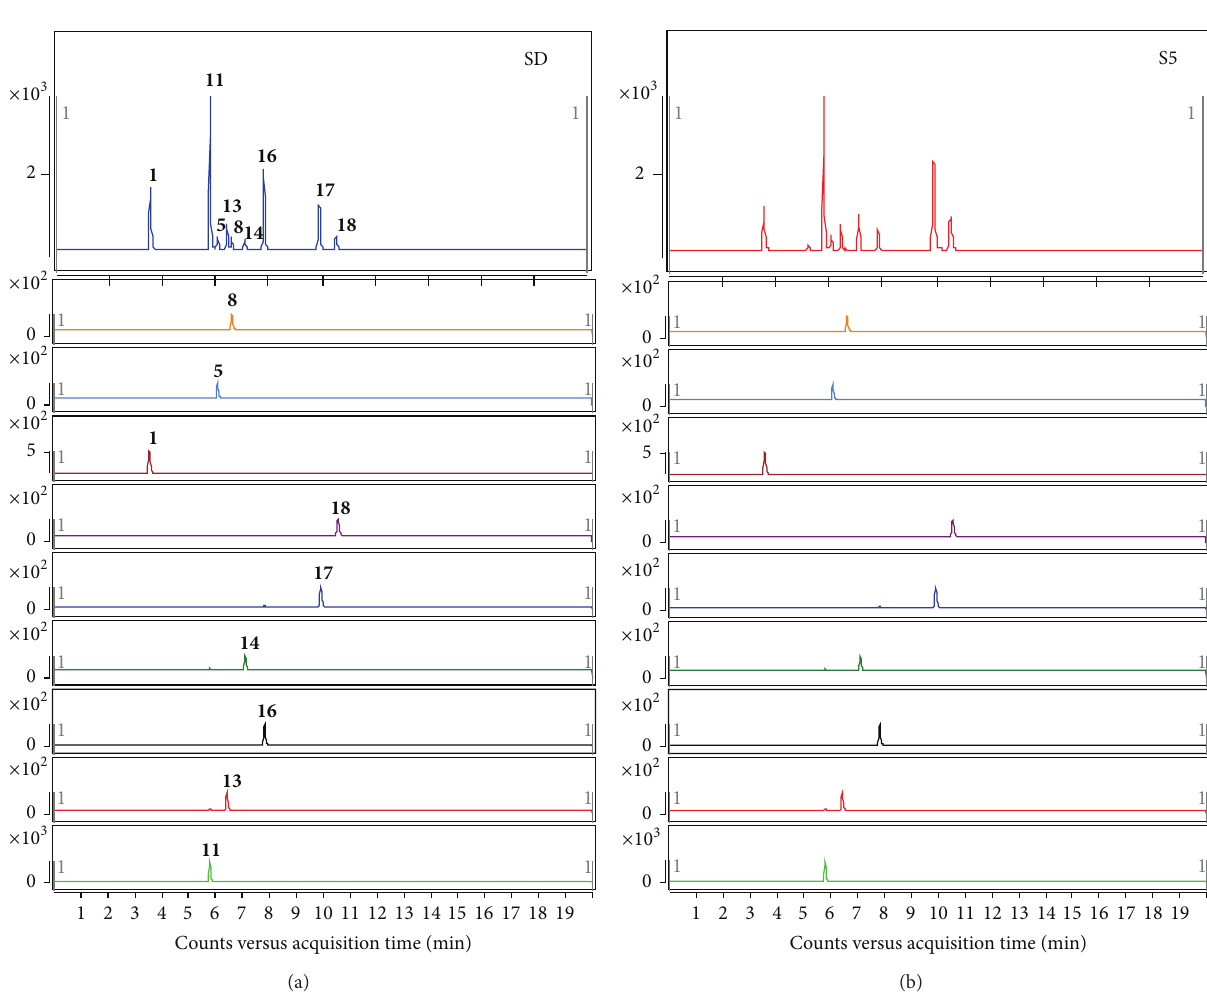
Figure 7: Typical MRM chromatograms of mix standard (a) and sample